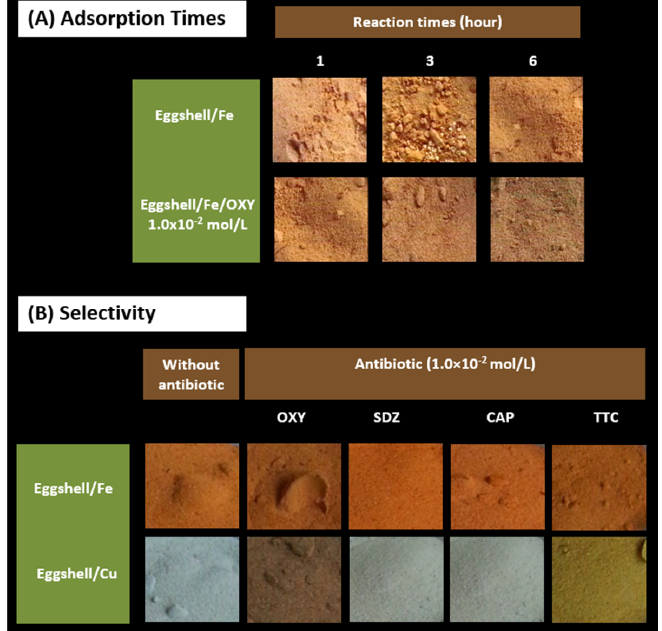
Figure 6. Effect of different adsorption time of the metal species to the eggshell ( A ), ranging between 1 and 6 h, and cross-response of the sensing materials ( B ) to other antibiotic drugs, set to the same concentration of the target antibiotic.